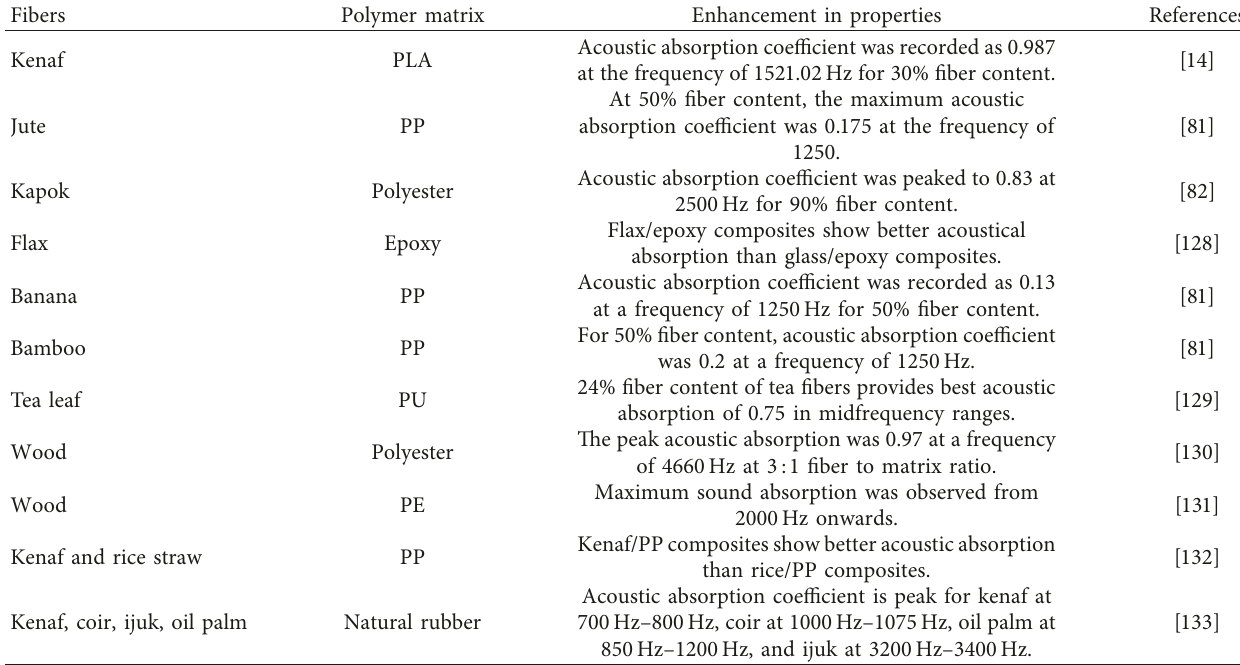
Table 13: Natural fibers with various polymer matrices and their resulting enhancement in acoustical properties. Fibers